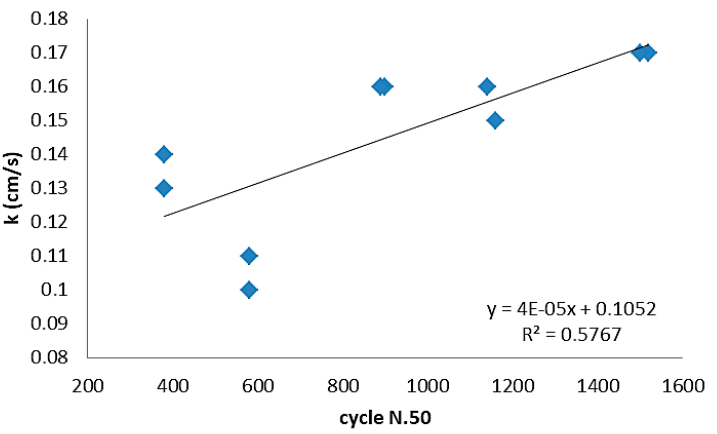
Figure 11. N. 50 cycle of the freeze–thaw test of the produced concrete specimens vs. the permeability coefficient of the produced concrete specimens.